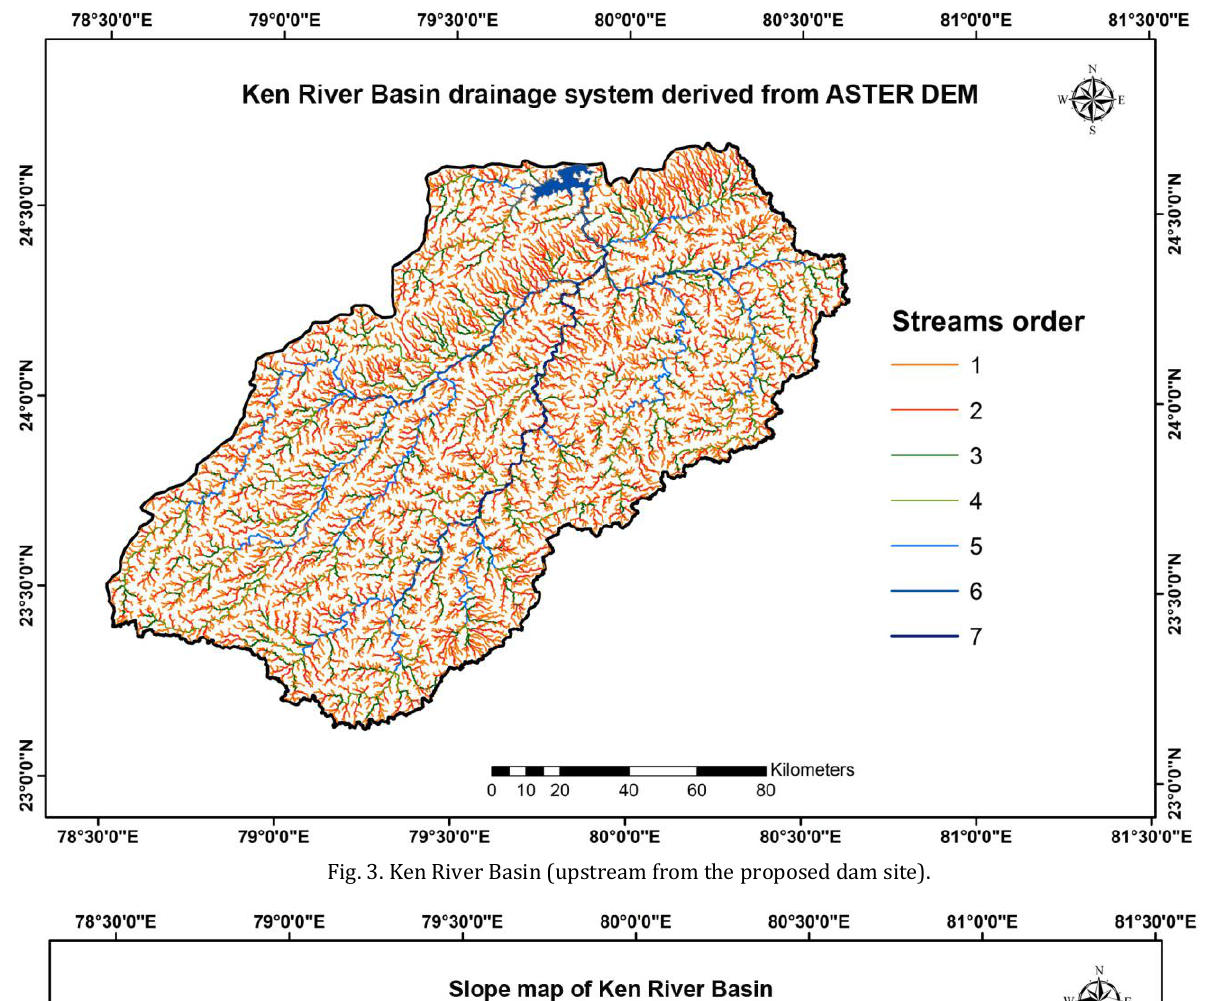
Fig. 3. Ken River Basin (upstream from the proposed dam site).